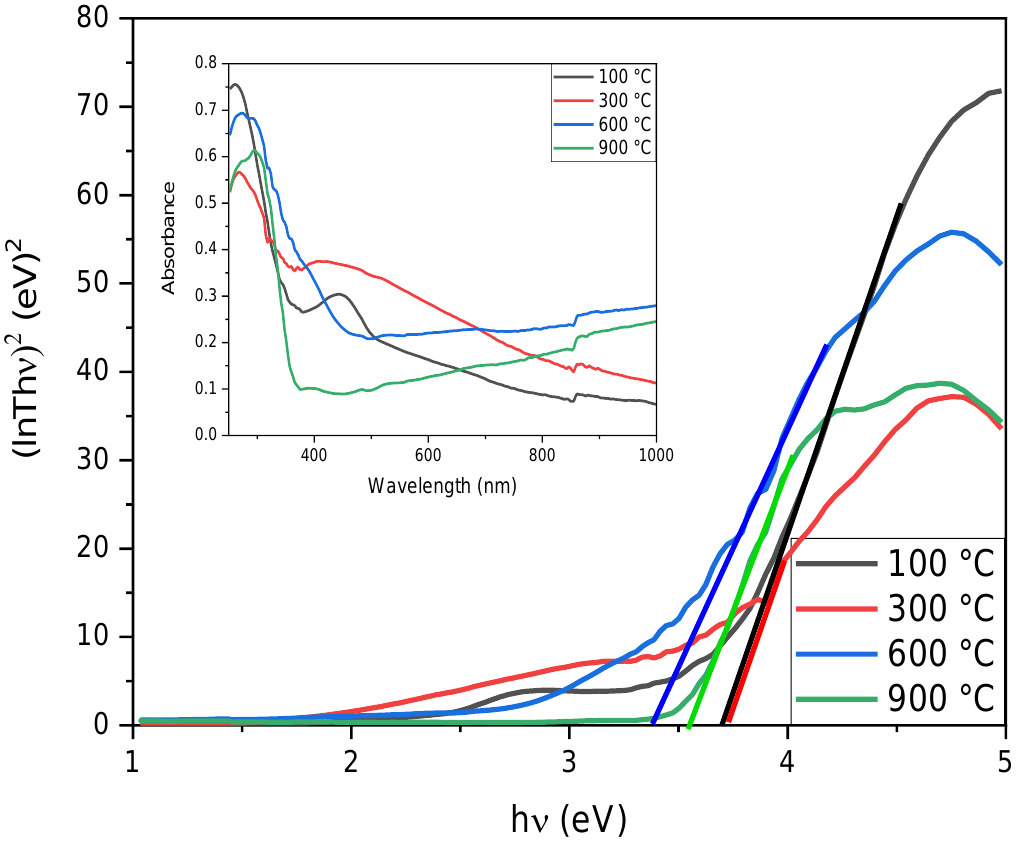
Figure 4. Tauc’s plot (inset : DRS spectra) of SnO 2 NPS calcined at the indicated temperatures. Upon comparing the optical and structural properties of the SnO 2 NPs calcined at different temperatures, an alternate blue and red shift was observed with increasing calcination. When the calcination increased from 100 ◦ C to 300 ◦ C, a blue shift was seen in the absorbance edge. At 300 ◦ C, the dehydration occurred, leading to the formation of a compact structure where maximum absorption or minimum reflectance of light is expected. A subsequent red shift for SnO 2 NPs calcined at 600 ◦ C might be due to the degeneration/infringement of the compact structure that might enhance the transmittance of light. The absorbance edge for the SnO 2 NPs calcined at 900 ◦ C was seen at a lower wavelength than that observed for the sample calcined at 600 ◦ C. This might be due to the rearrangement of small particles, leading to the formation of a bit larger particles with a rough surface and a larger surface defect. The as-calculated band gap energy values via Tauc’s plot are 3.70, 3.72, 3.38, and 3.55 eV for the SnO 2 NPs calcined at 100, 300, 600, and 900 ◦ C (Figure 4). The initial slight increase in the band gap with the elevation in temperature from 100 to 300 ◦ C is attributed the phase transition from unknown crystal system to tetragonal crystal phase [30]. The significant decrease occurred in the band gap at 600 ◦ C could be ascribed to the complete dehydration and formation of a compact large size solid structure. The slight increase in the band gap at 900 ◦ C, is more likely due to the small size of particles formation due to cracking compact solid into small